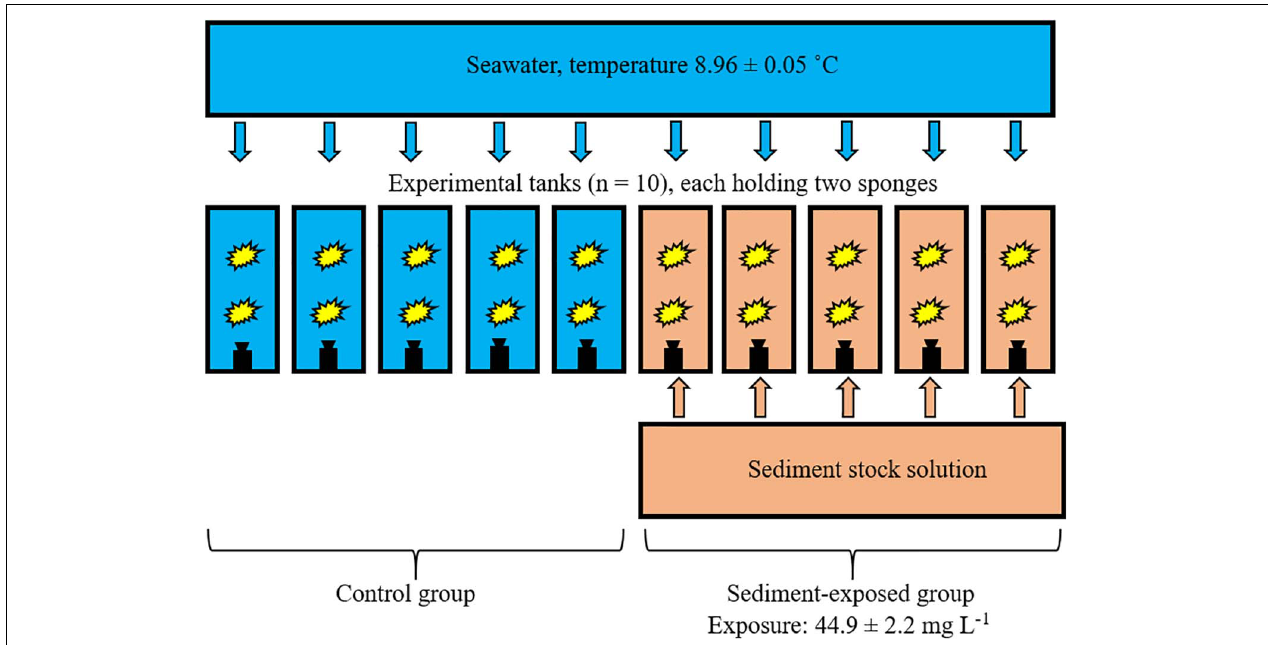
FIGURE 3 | Experimental design used in this study. Ten individual tanks, each holding two sponges (yellow shapes), were supplied with sea water. Each tank was equipped with a pump (black shapes). Five tanks received dosages of a sediment stock solution for 12 h per day.